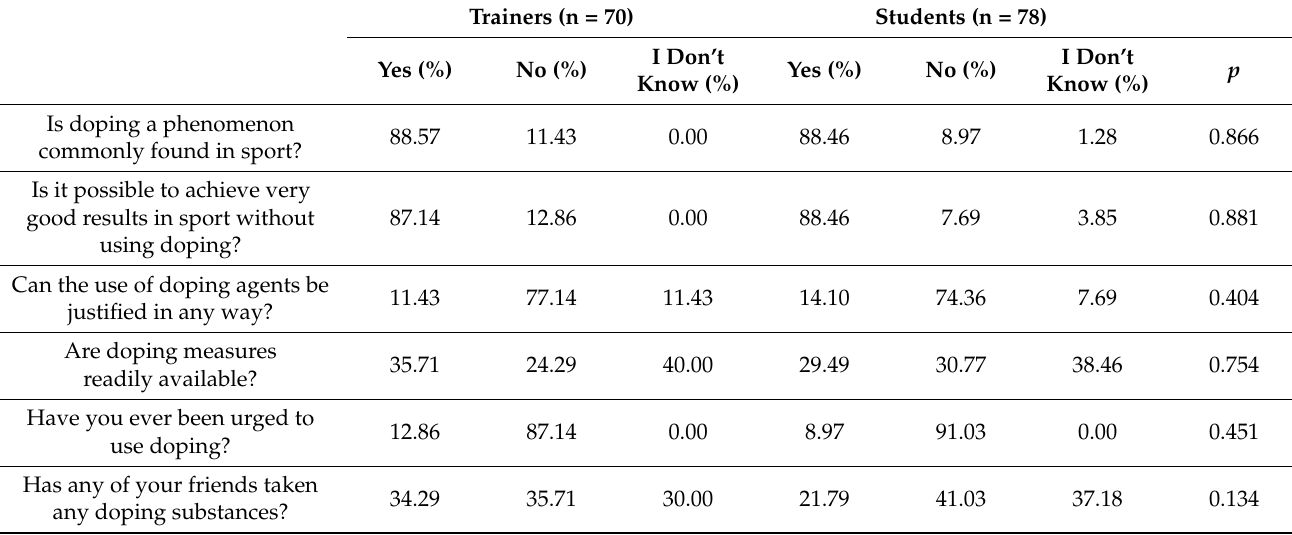
Table 1. The use of doping agents in the studied